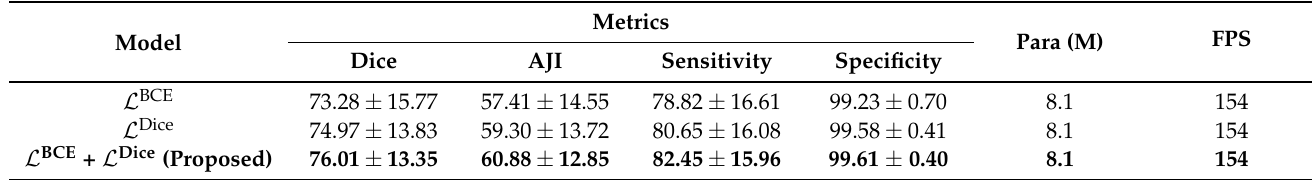
Table 2. Ablation study of the loss functions. The best results are highlighted in bold.